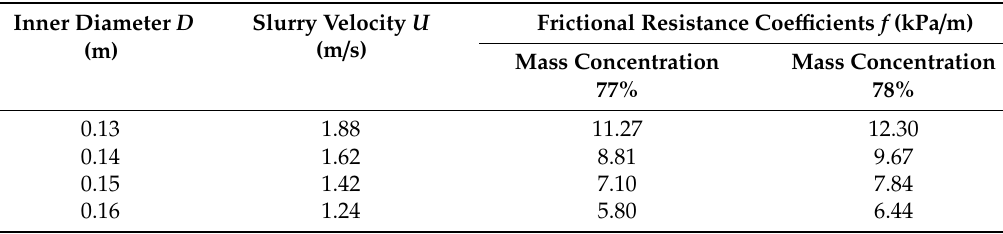
Table 5. Friction resistance coe ffi cients under di ff erent pipe